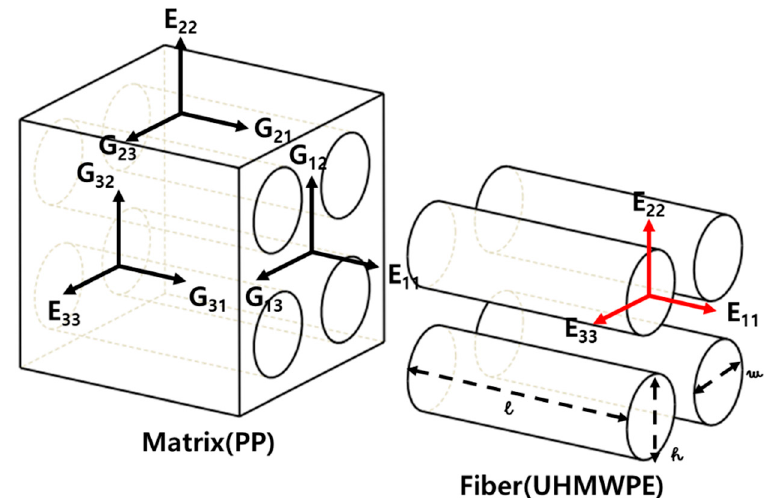
Figure 1. Tensor notation of fiber-reinforced composite materials.